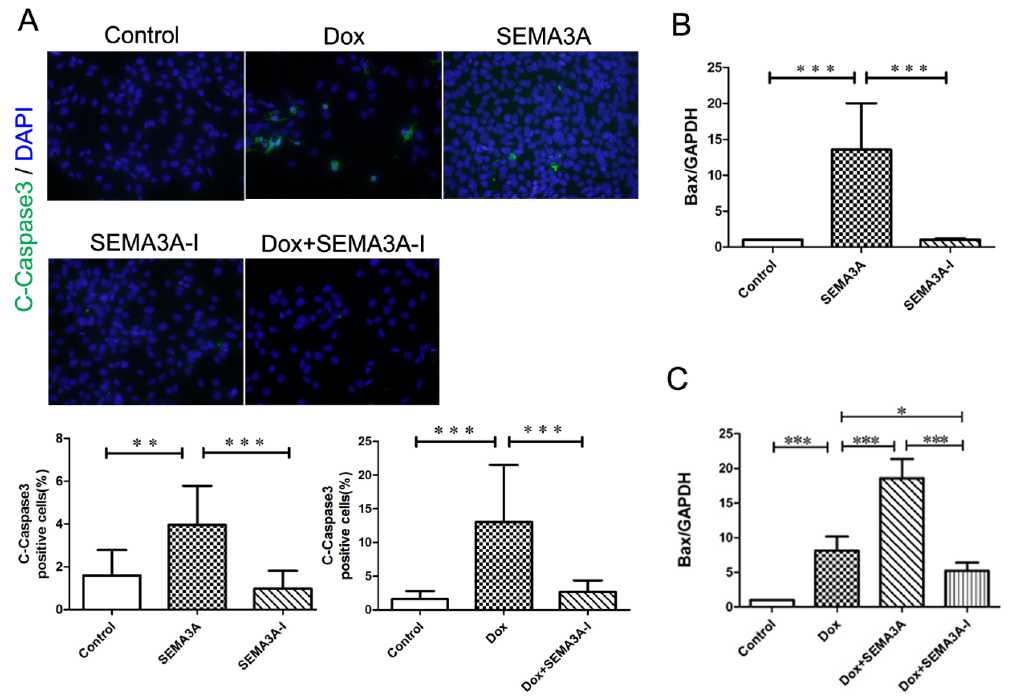
Figure 5. SEMA3A caused podocyte apoptosis while SEMA3A-inhibitor protected from podocyte apoptosis. ( A ) Representative immunofluorescence staining images of cleaved-caspase3 (C-Caspase3) (green) and DAPI (blue) in podocytes with or without Dox (0.5 µ g / mL), SEMA3A (50 ng / mL), SEMA3A-I (0.5 µ M), and Dox (0.5 µ g / mL) + SEMA3A-I (0.5 µ M). Original magnification, × 200. C-Caspase3-positive cells / nuclei (%) in 200 × field are shown in the graphs. ( B , C ) RT-qPCR analysis of Bax and GAPDH mRNA with or without SEMA3A (50 ng / mL), SEMA3A-I (0.5 µ M), Dox (0.5 µ g / mL), Dox (0.5 µ g /